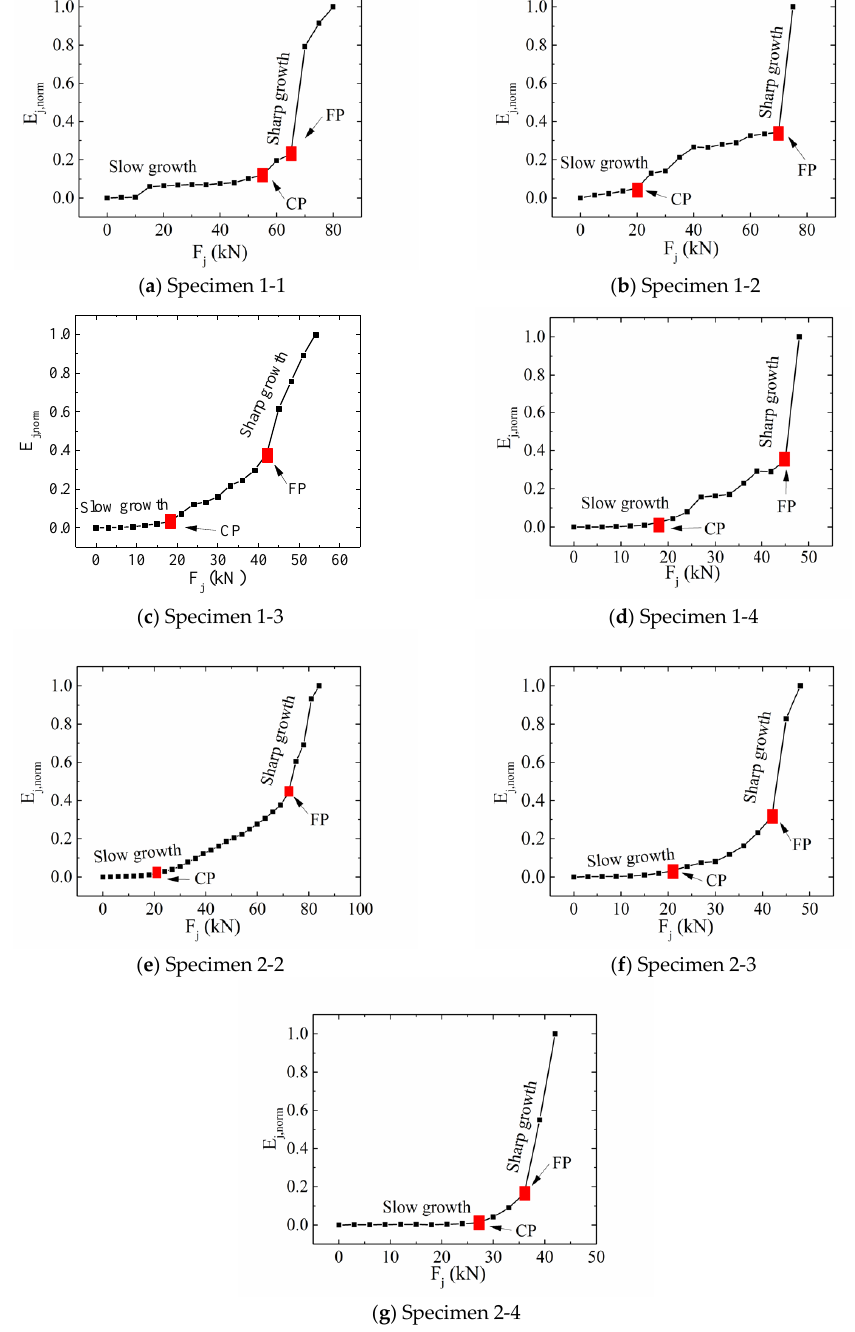
Figure 11. The F j − E j ,norm curves of the specimens. Note: CP is the cracking load point; FP is the Figure 11. The ,norm j j F E  curves of the specimens. Note: CP is the cracking load point; FP is the failure load failure load point.